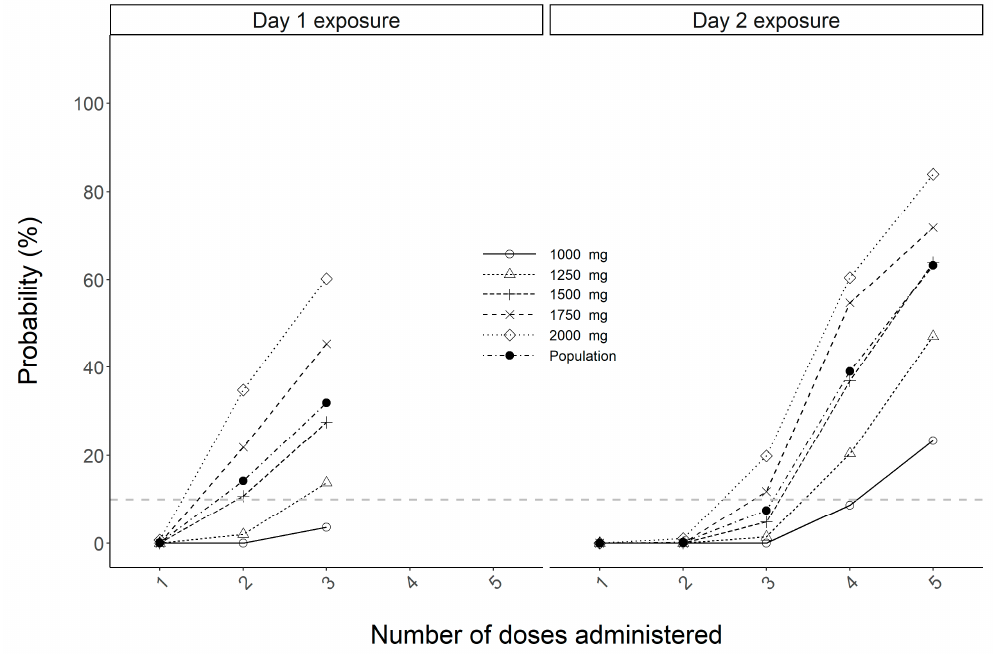
Figure 5. Maternal probability of target attainment for the toxicity index of the AUC above 600 mg·h/L. Broken grey horizontal line represents the cutoff of 10%.